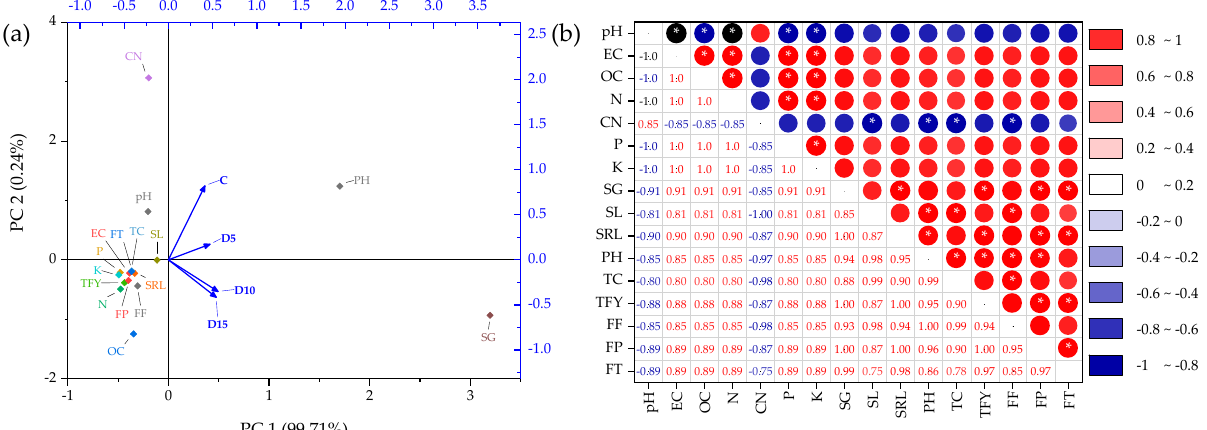
Figure 5. PCA biplot ( a ) and Pearson correlation matrix ( b ) for the effects of SMS digestate on the response of tomato (PC: principal component; D: SMSD load as %; EC: electrical conductivity; OC: organic carbon; N: nitrogen; CN: carbon to nitrogen ratio; P: phosphorus; K: potassium; SG: seedling germination; SL: seedling length; SRL: seedling root length; PH: plant height; TC: total chlorophyll; TYF: total fruit yield; FF: fruit flavonoids; FP: fruit phenolics; FT: fruit tannins).